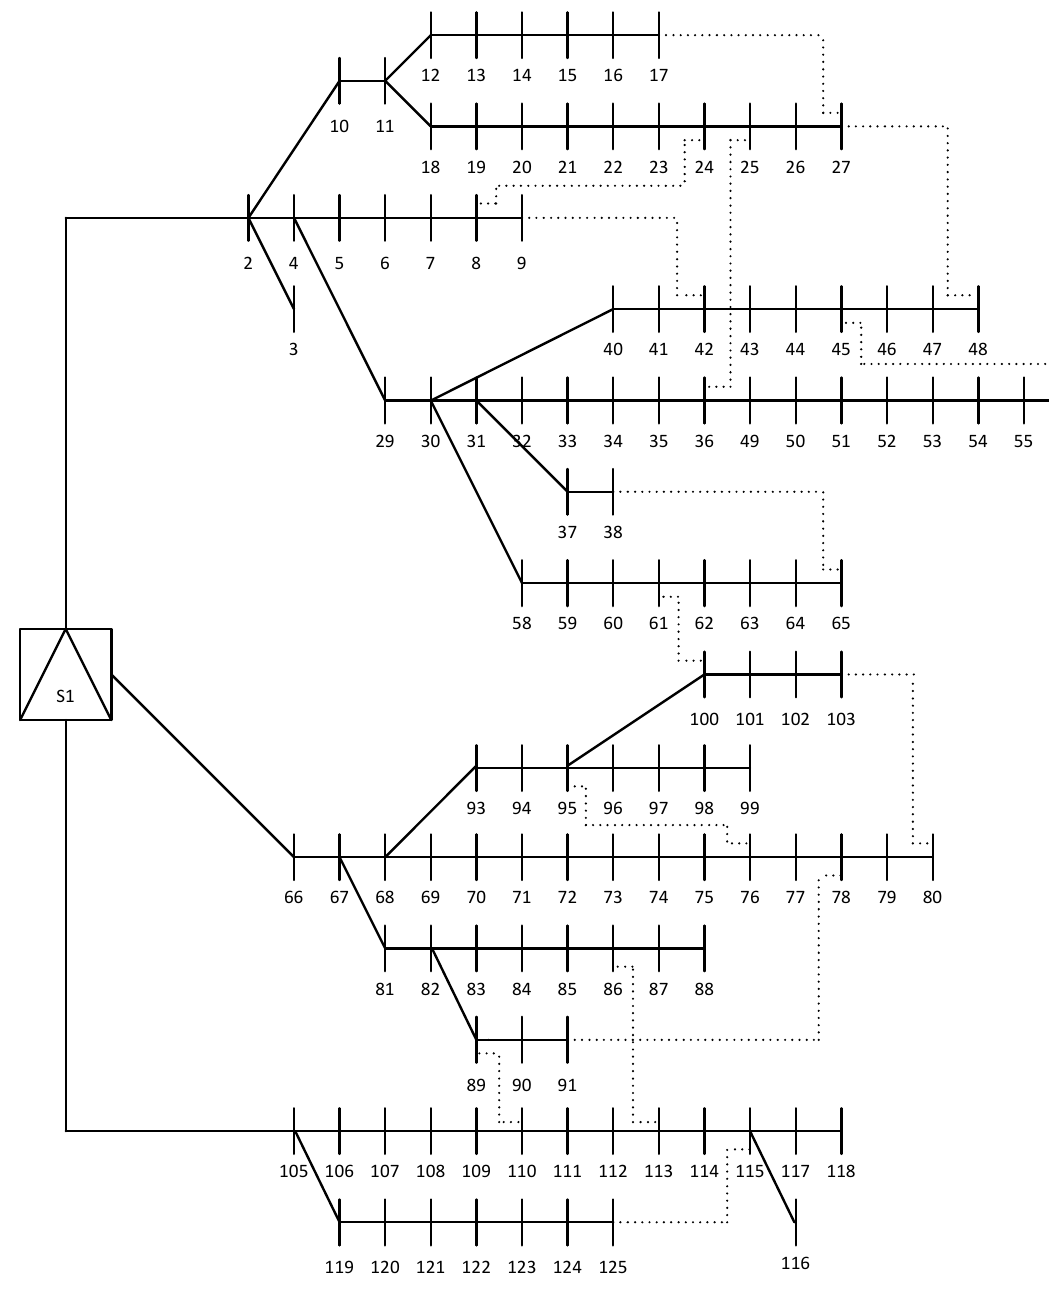
8 Table 5. The maximum transfer capacity in feeders. Feeders